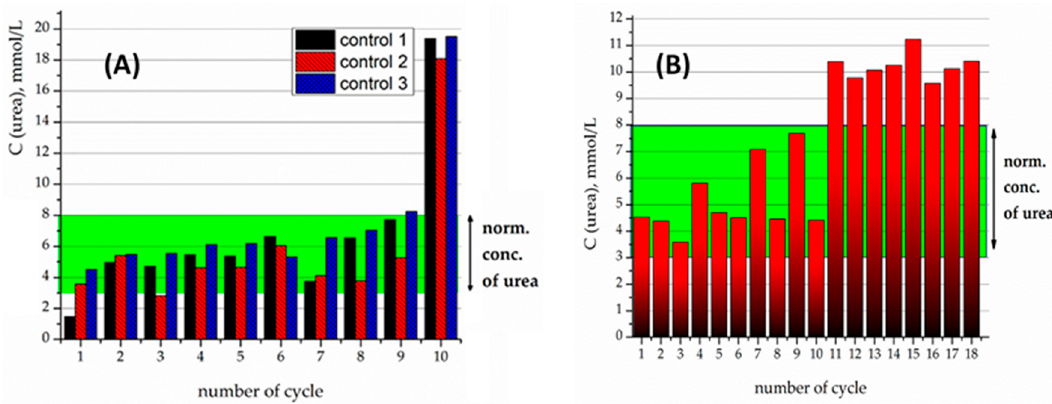
Figure 5. Hydrolysis of pathologic concentration of urea in the isotonic buffer by: ( A ) Fe 3 O 4 /SiO 2 -NH 2 -DTPA-Urease nanocomposite, 5% crosslinking by glutaraldehyde; three control iterations (cycle 10—blank, 20 mmol/L of urea); ( B ) Fe 3 O 4 /SiO 2 -NH 2 -DTPA-Urease nanocomposite, 5% crosslinking by glutaraldehyde; 18 cycles (contact time: cycle 1–10—2 min; cycle 11–18—1 min).